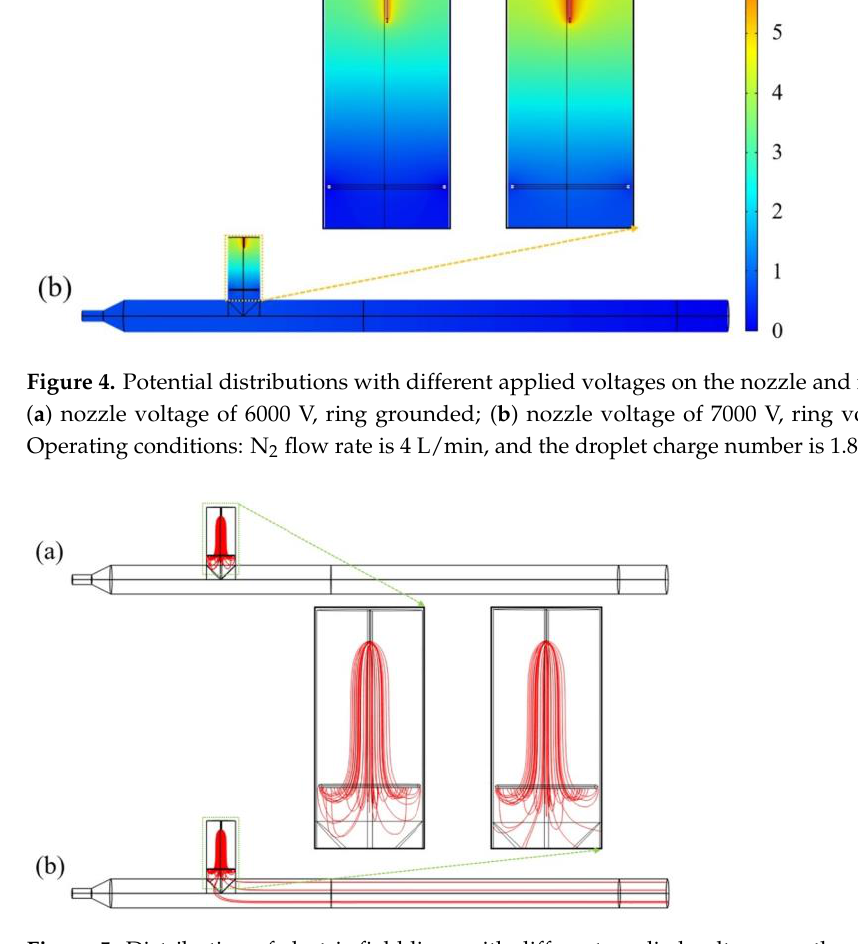
Figure 5. Distribution of electric field lines with different applied voltages on the nozzle and ring electrodes: ( a ) nozzle voltage of 6000 V, ring grounded; ( b ) nozzle voltage of 7000 V, ring voltage of 500 V. Operating conditions: N 2 flow rate is 4 L/min, and the droplet charge number is 1.84 × 10 − 13 C.